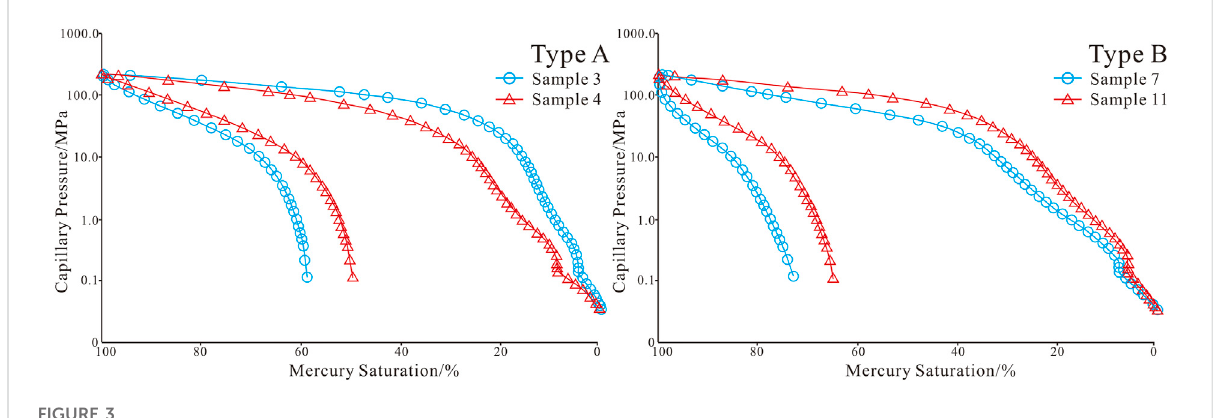
FIGURE 3 Mercury injection-ejection